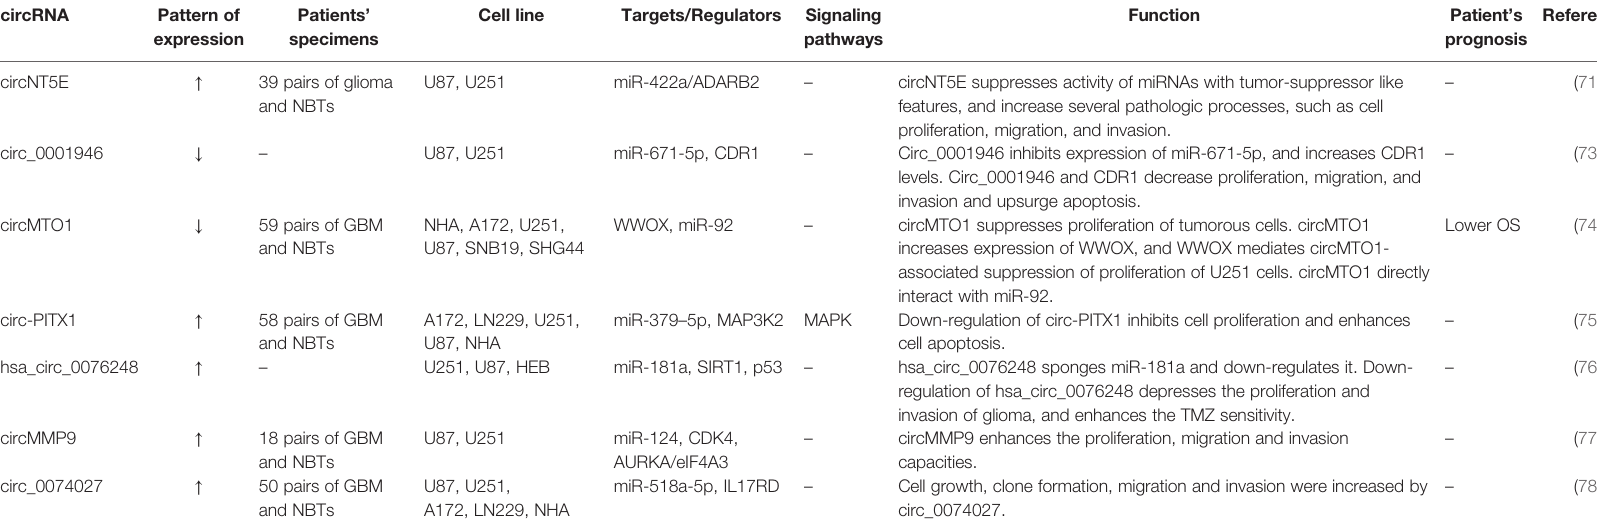
TABLE 4 | List of circRNAs which participate in the development of